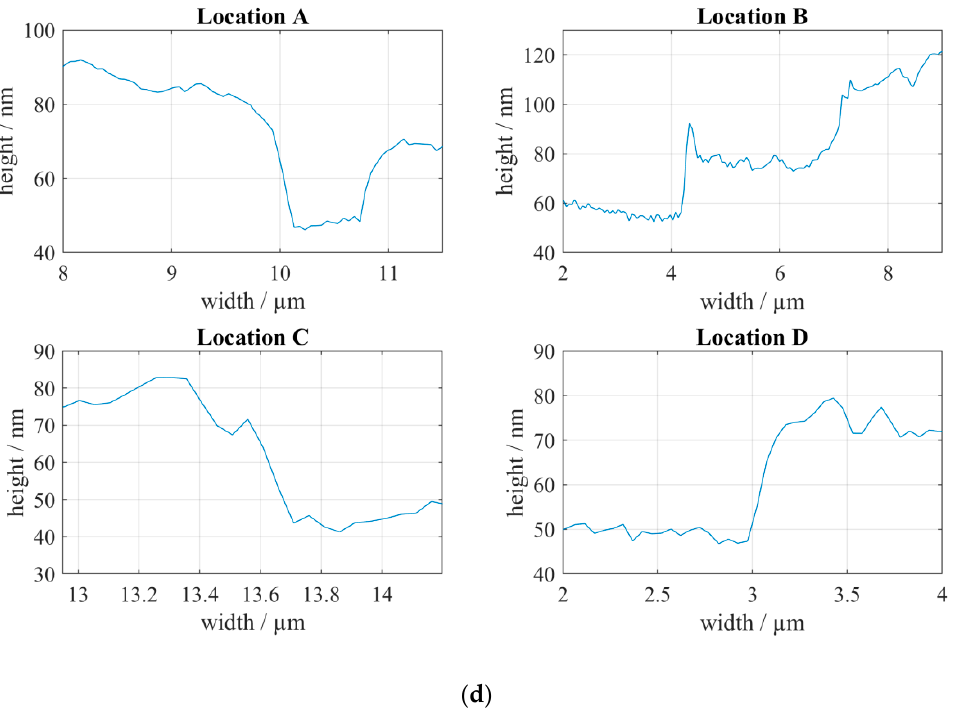
Figure 7. SEM and AFM of the detached portion of the film held on the surface of the sample by electrostatic interaction: ( a ) large area SEM image; ( b ) detailed SEM image; ( c ) AFM image of the region of interest; ( d ) profiles of the chosen areas of the AFM image.